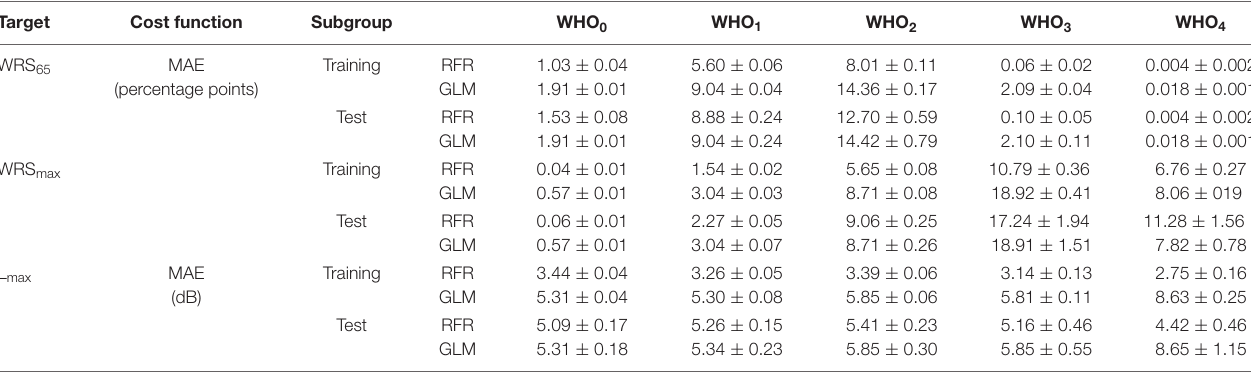
TABLE 4 | Median absolute error and its standard error of the RFR and GLM model for the monosyllabic score at a presentation level of 65 dB SPL (WRS 65 ), the maximum word recognition score (WRS max ) and the presentation level for the maximum word recognition score, L max .